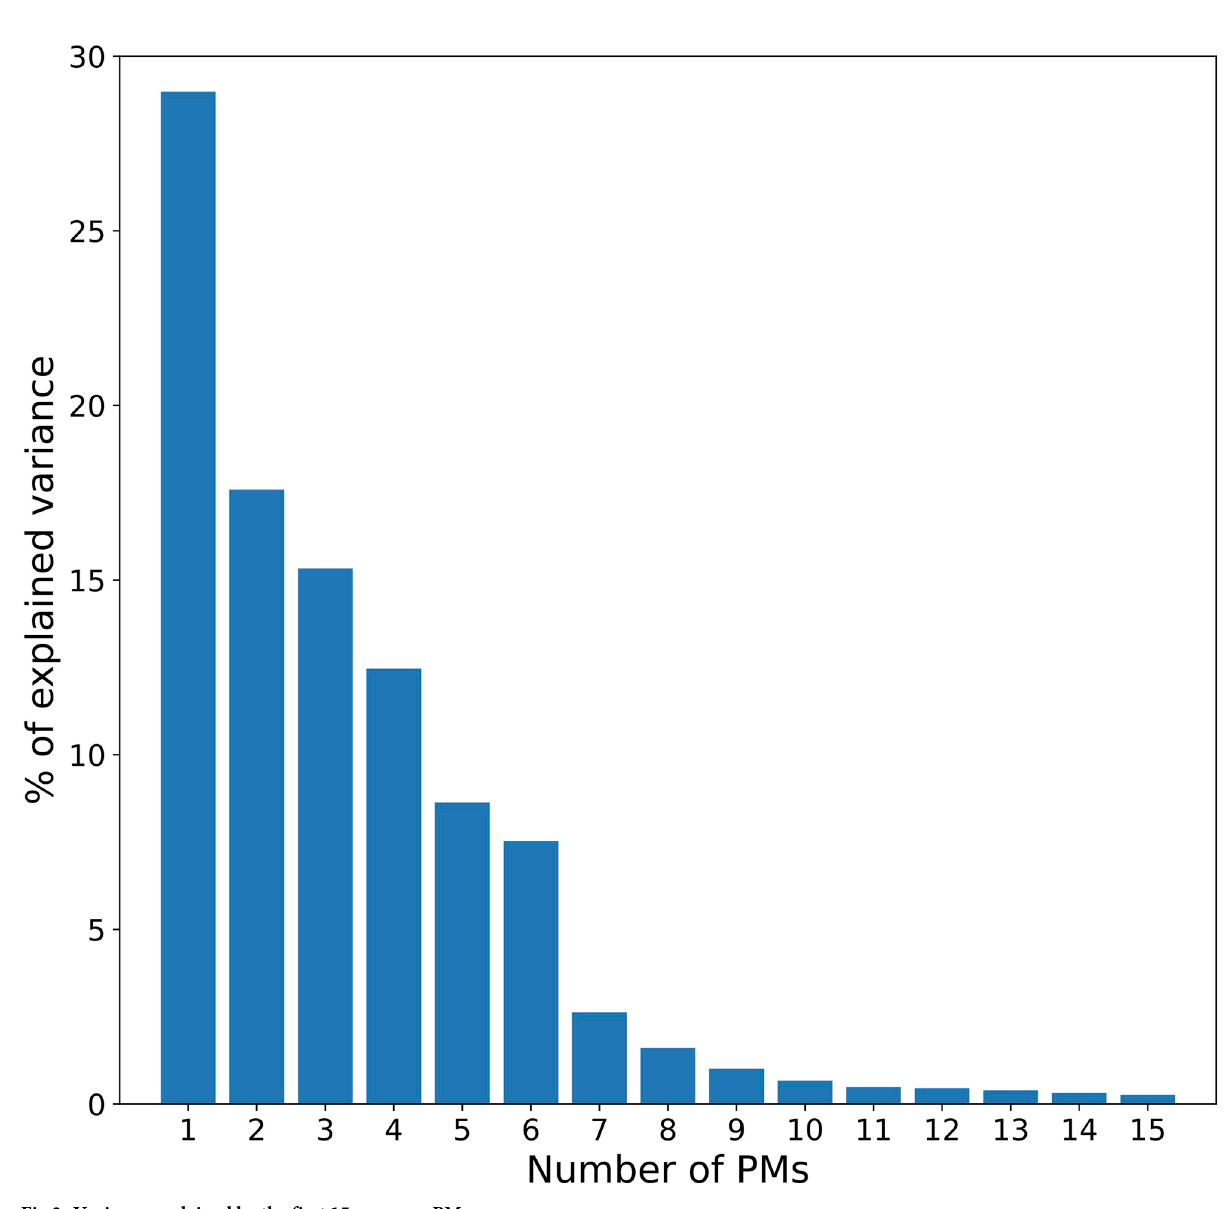
Fig 2. Variance explained by the first 15 common